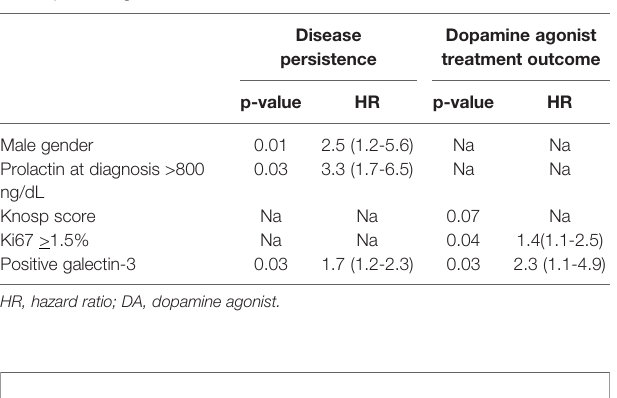
TABLE 4 | Logistic regression of variables associated to disease persistence and dopamine agonist treatment outcome.